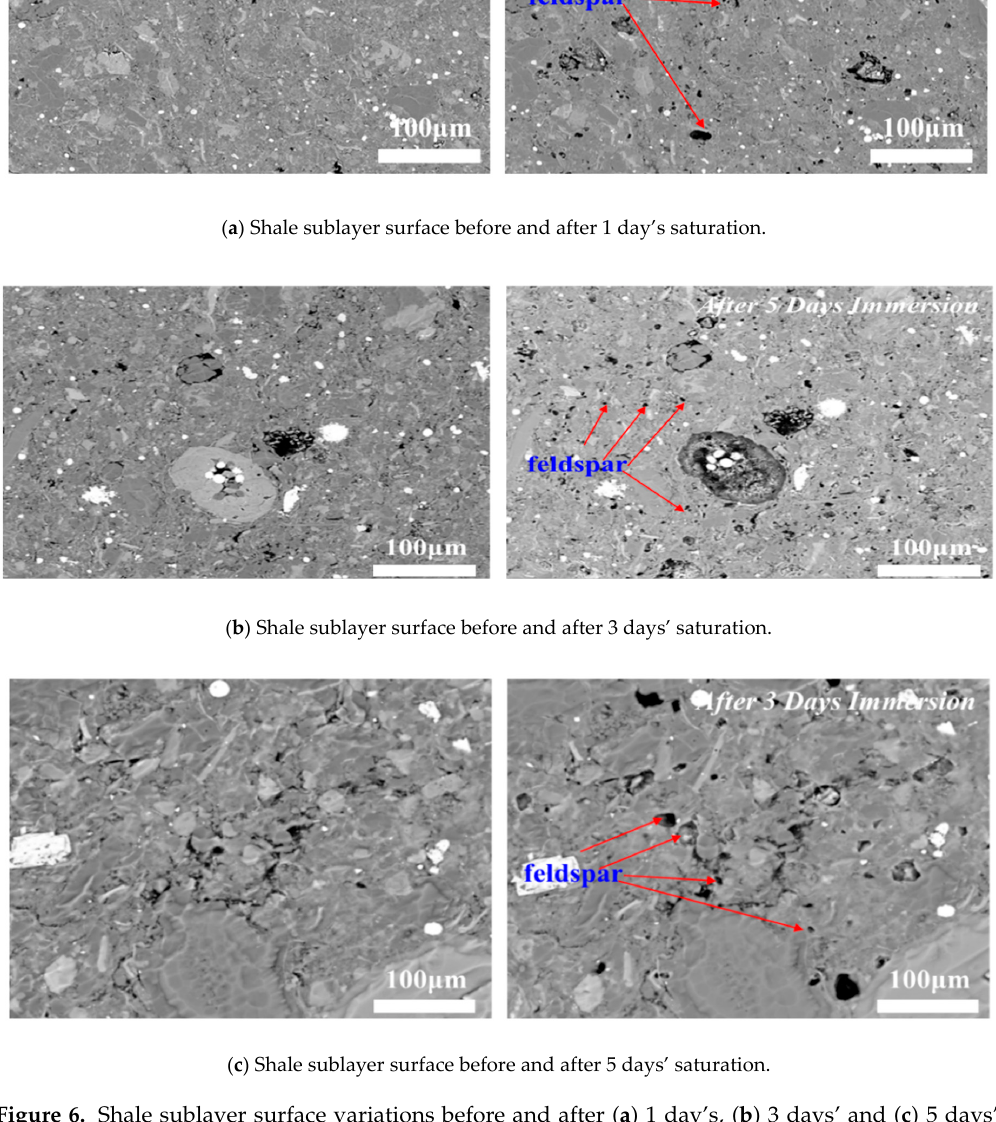
Figure 6. Shale sublayer surface variations before and after ( a ) 1 day’s, ( b ) 3 days’ and ( c ) 5 days’ saturation for the imbibition perpendicular to bedding planes at pressure of 3.5 MPa and temperature of 80 °C.